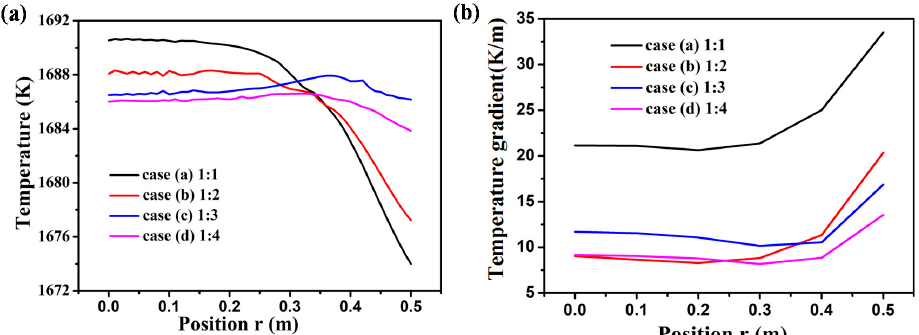
Figure 5. Radial and axial temperature distribution when the solidification fraction was 50%. ( a ) Radial temperature distribution on the horizontal plane ( z = 1.0 m) and ( b ) axial temperature gradient between the plane of z = 1.0 m and the plane of z = 1.2 m.